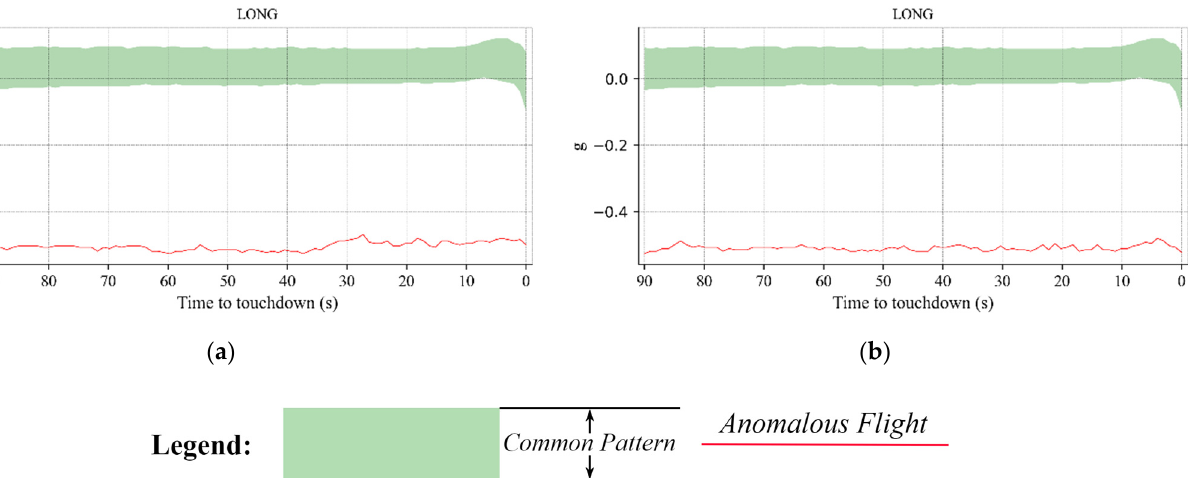
Figure 12. The two anomalous flights within the 𝑂 (cid:2870) collection. As illustrated, ( a,b ) show the power use of the two anomalous lower power use of the two anomalous flights.